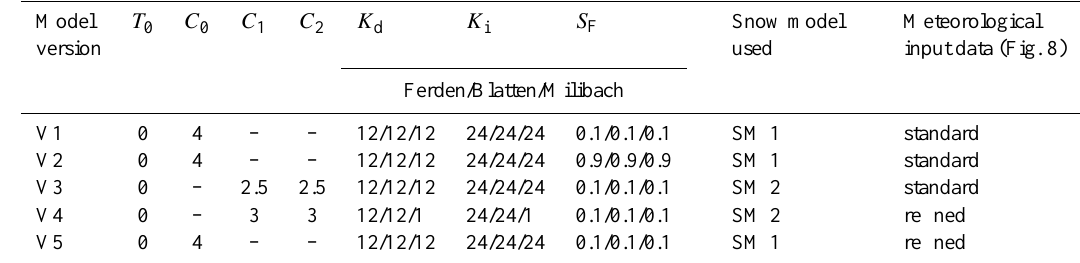
Table 2. Summary of the most important parameters, snowmelt algorithms, and meteorological input data applied in the different model